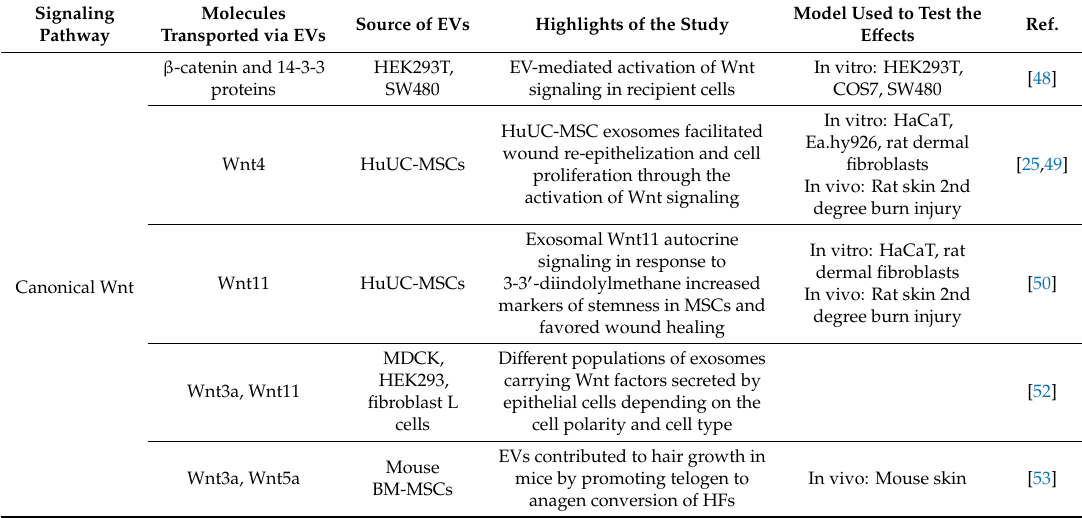
Table 1. The role of extracellular vesicles in signaling pathways with the potential to modulate hair